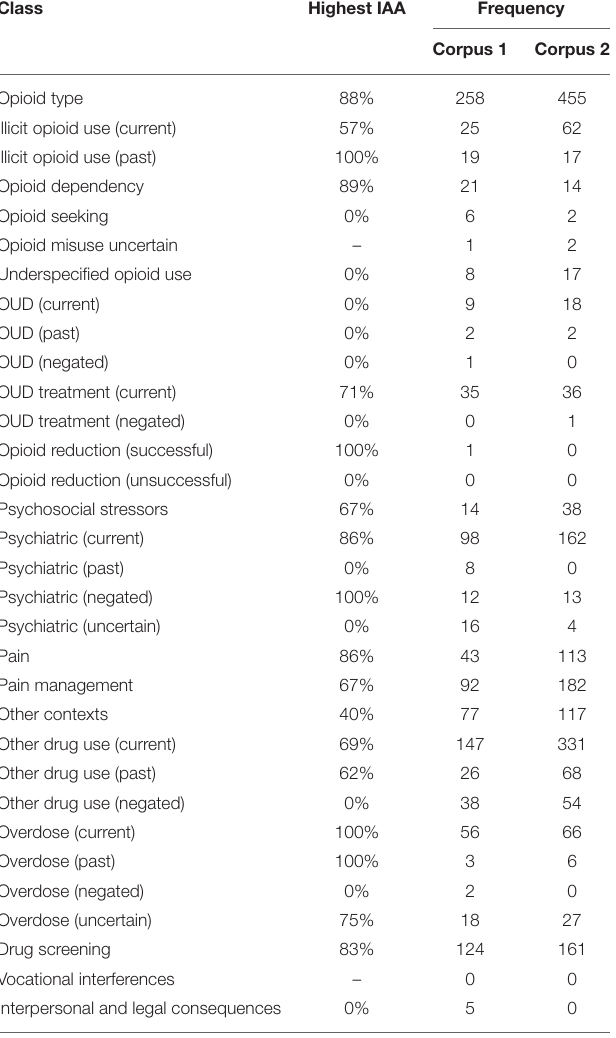
TABLE 2 | Highest achieved IAA (based on class overlap) of each class, and frequency of use for each corpus of discharge